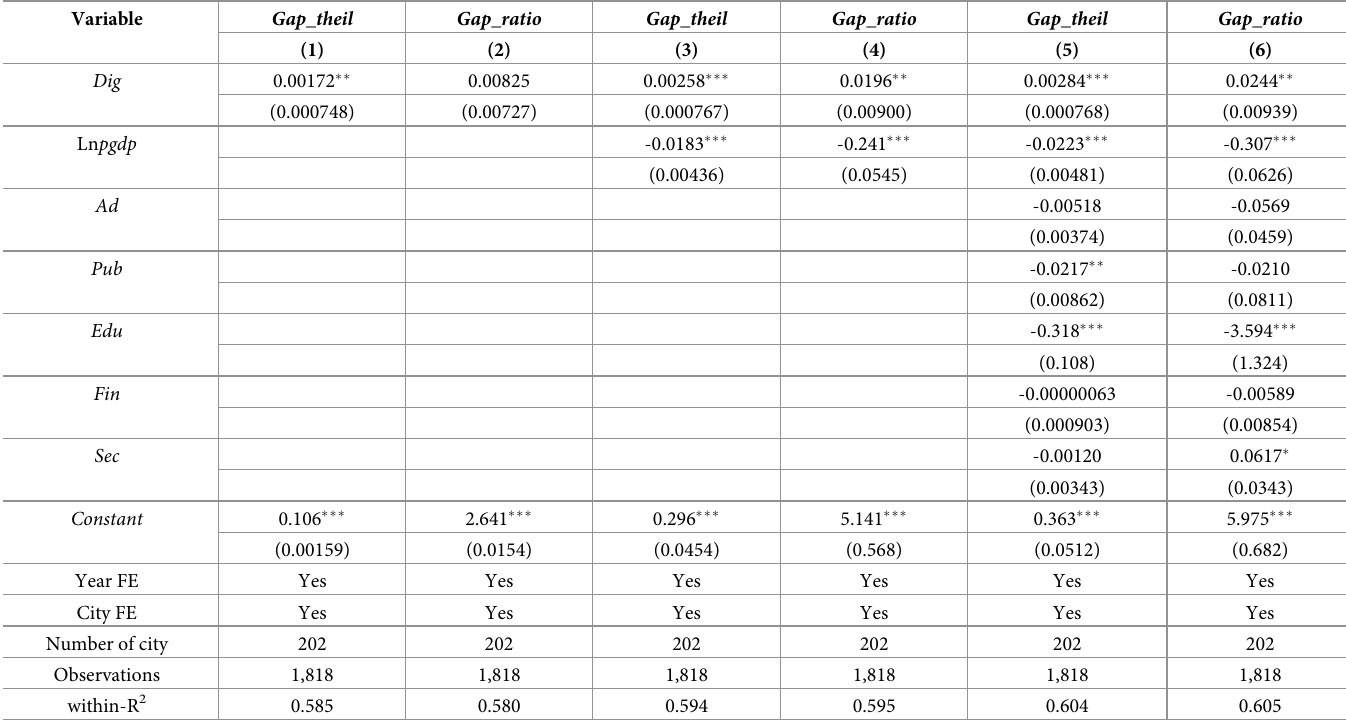
Fig 5. Kernel density estimation of the urban-rural income gap by areas. https://doi.org/10.1371/journal.pone.0280225.g005 Table 2. Benchmark regression